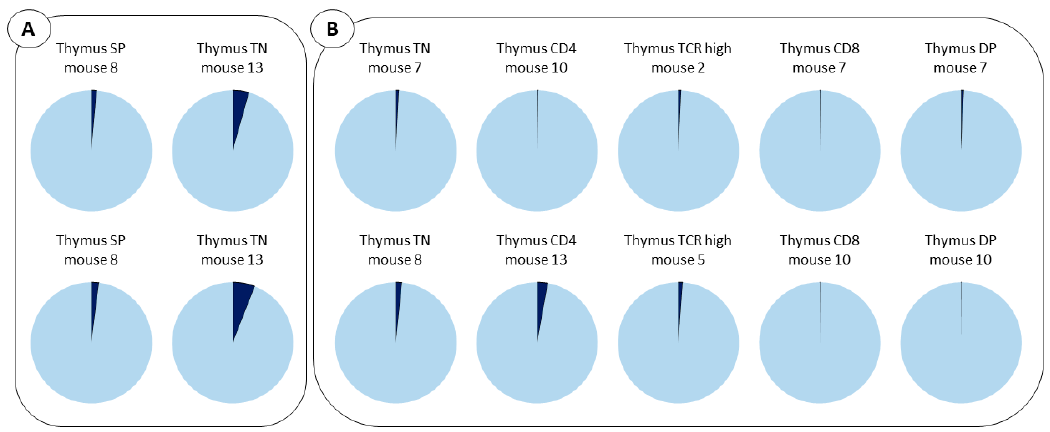
Figure 8. Barcodes analysis in multiple mice and subsets. ( A ). Results of thymus SP (CD4 + or CD8 + ) and thymus TN (CD3 − CD4 − CD8 − ) obtained for the same mouse in two independent experiments. ( B ). BC composition of thymus N, CD4, TCR high, CD8 and DP (CD4 + CD8 + ) analyzed in different mice. LMPP BCs are shown in light blue and CLP in dark blue.